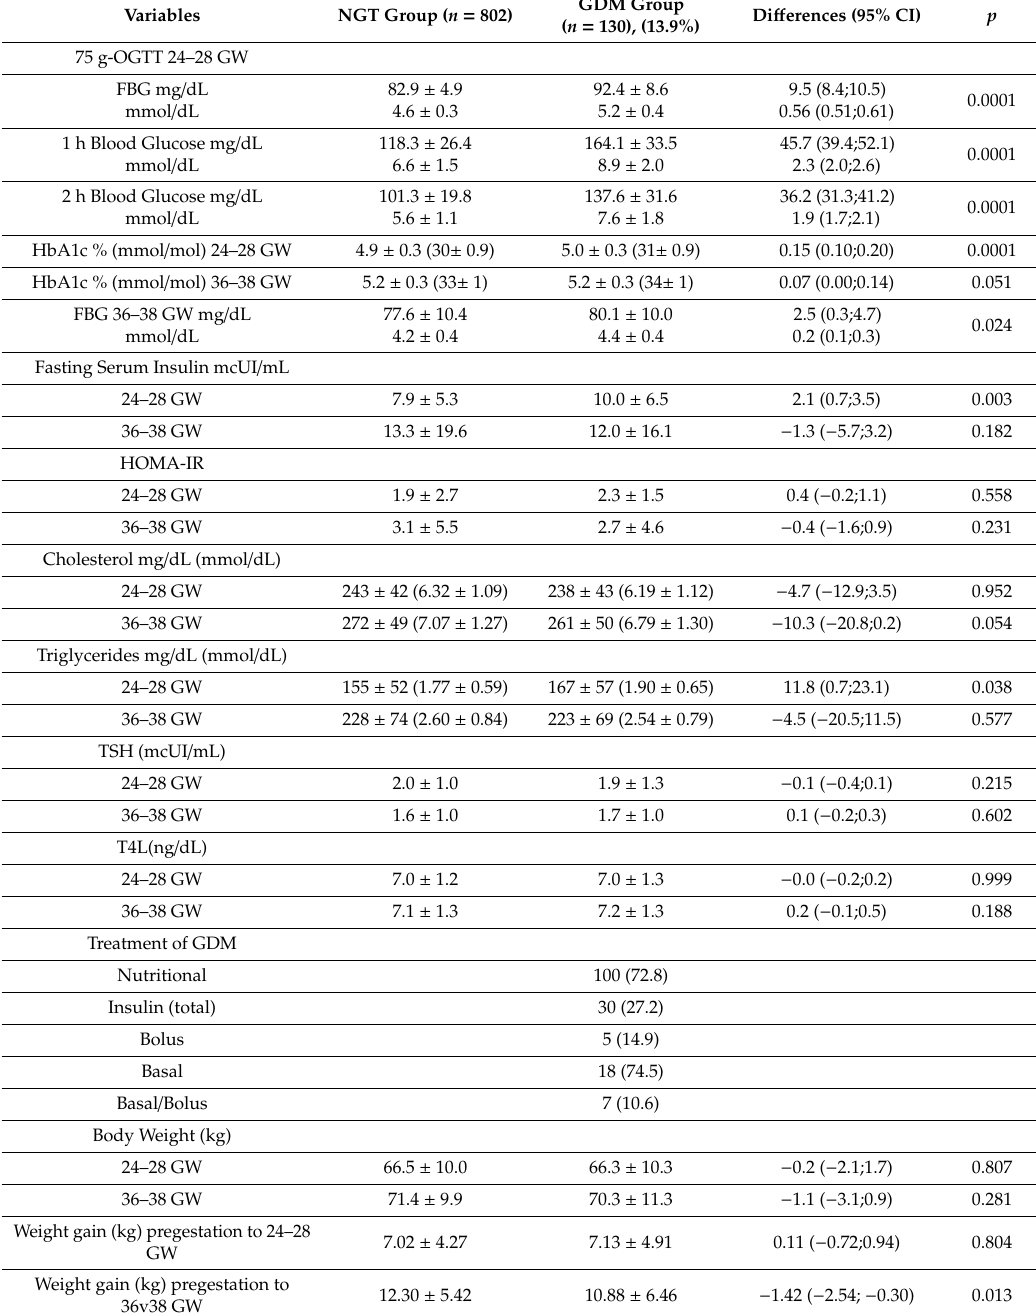
Table 2. Maternal clinical, biochemical and anthropometric data at 24–28 and 36–38 gestational weeks